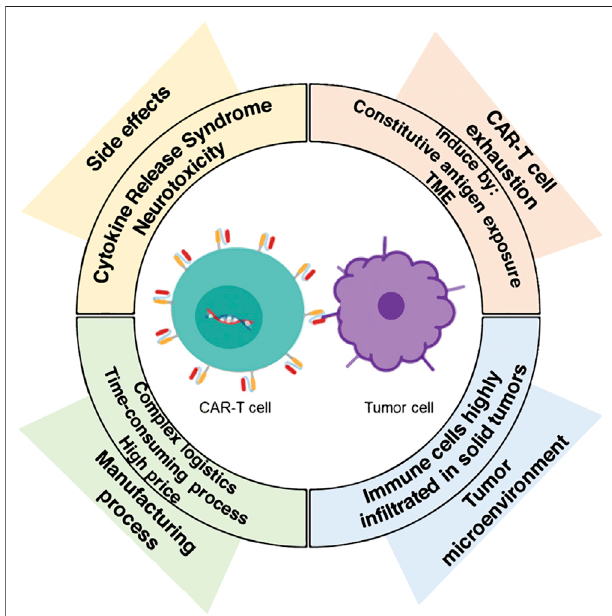
FIGURE2| ThemajorchallengesinCAR-Timmunotherapy.Nowadays, the novel CAR-T cells therapy does face some signi fi cant challenges, such as sideeffects,ahostiletumormicroenvironment(TME),andT-cellexhaustion.In addition, the challenge of scaling-up the manufacture of clinical-grade cell therapies needs to be addressed to make them available and affordable for more patients